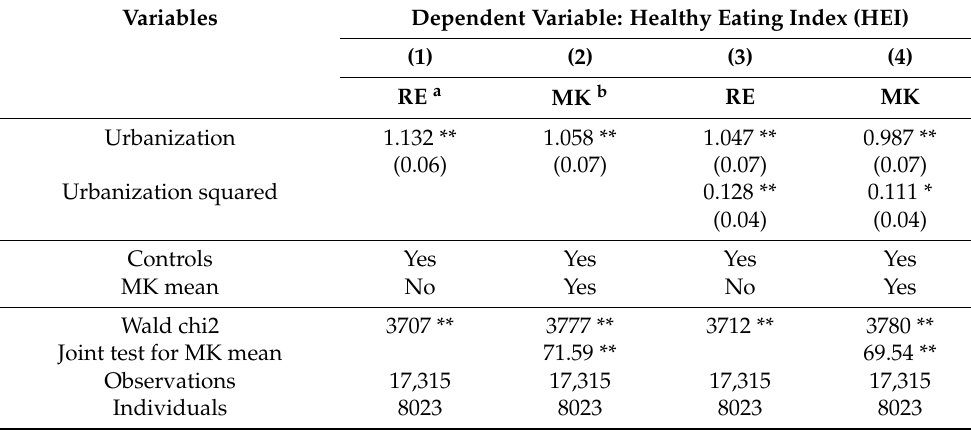
Table 5. The effect of urbanization on the Healthy Eating Index (HEI).